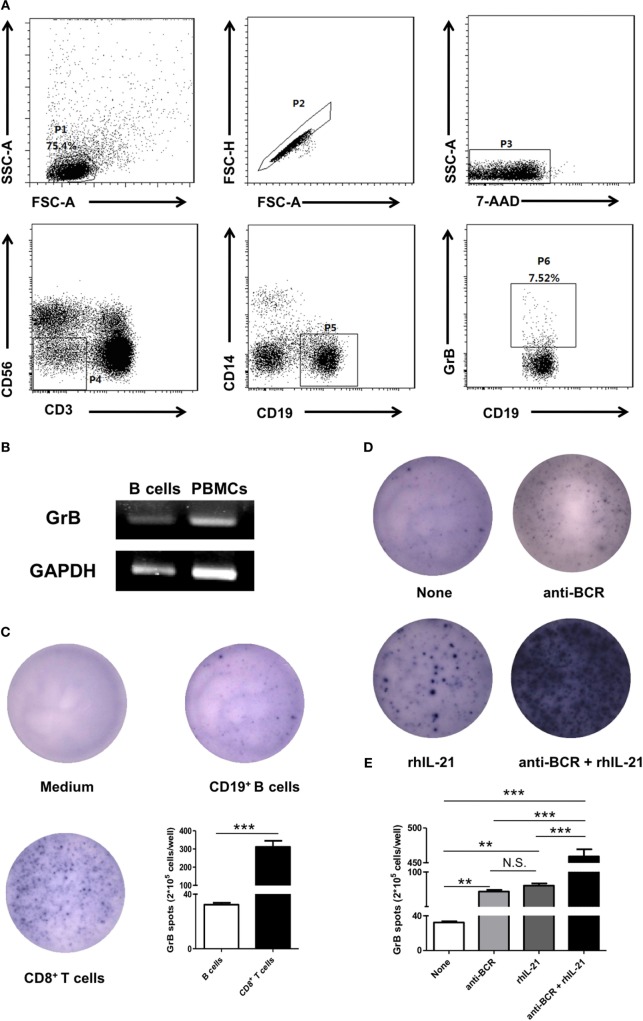
B cells in human peripheral blood produced and secreted GrB spontaneously. (A) Peripheral blood mononuclear cells were isolated from healthy individual fresh peripheral blood and incubated with phorbol 12-myristate 13-acetate (50 ng/ml), ionomycin (1 µg/ml), and Brefeldin A (10 µg/ml) for 5 h. Intracellular expression of GrB was detected in B cells by staining with anti-CD19 antibody, anti-CD3 antibody, anti-CD56 antibody, anti-CD14 antibody, and anti-GrB antibody. Dead cell exclusion was performed by scatter profiles and 7-ADD staining. FACS gating strategy and the representative scatter diagram from 15 healthy individuals were shown. (B) The GrB mRNA expression of purified CD19+ B cells (2 × 105) was determined by PCR. The transcript of human GAPDH gene was used as an amplification control. The representative data of five independent experiments were shown. (C) 2 × 105 freshly FACS-sorted CD19+ B cells (middle) from healthy individuals were cultured with CpG stimulation (10 µg/ml) on GrB-specific ELISpot plates for 24 h. Medium and CD8+ T cells were used as blank control and positive control, respectively, then dots were counted. Shown was representative of independent data from six different donors. (D,E) 2.5 × 105 CD19+ B cells per well were cultured on GrB-specific 96-well ELISpot plates under CpG stimulation (10 µg/ml) with or without following stimuli: recombinant human IL-21 (rhIL-21) (50 ng/ml) and/or anti-B-cell receptor (BCR) (10 µg/ml) as indicated, then plates were developed for 24 h and dots were counted. One representative experiment out of five (D) and the statistical results were shown (E). **P < 0.01, ***P < 0.001, N.S., no significance, by Student’s t-test, one-way ANOVA with post hoc Dunnett’s t test. GrB, granzyme B.